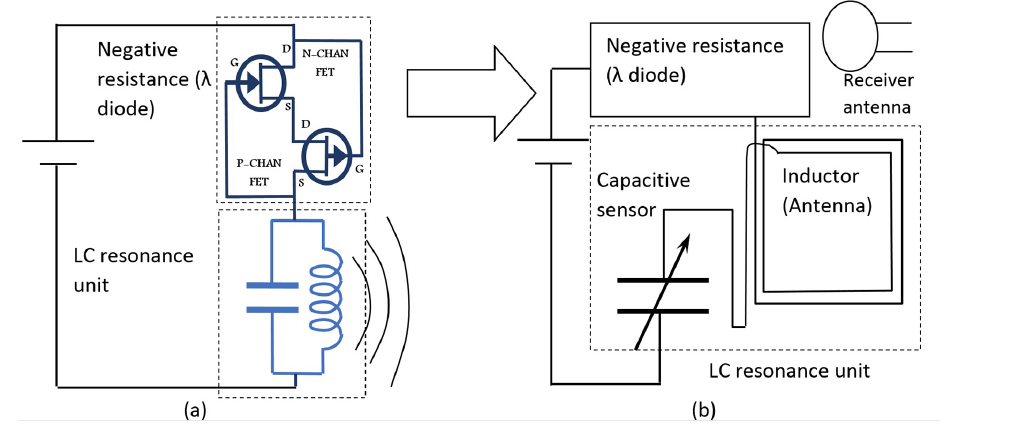
Figure 21. (a) Negative resistance oscillator schematic; (b) capacitive sensor read-out and transmission circuit. Electronic circuit design published by Butler (1997).